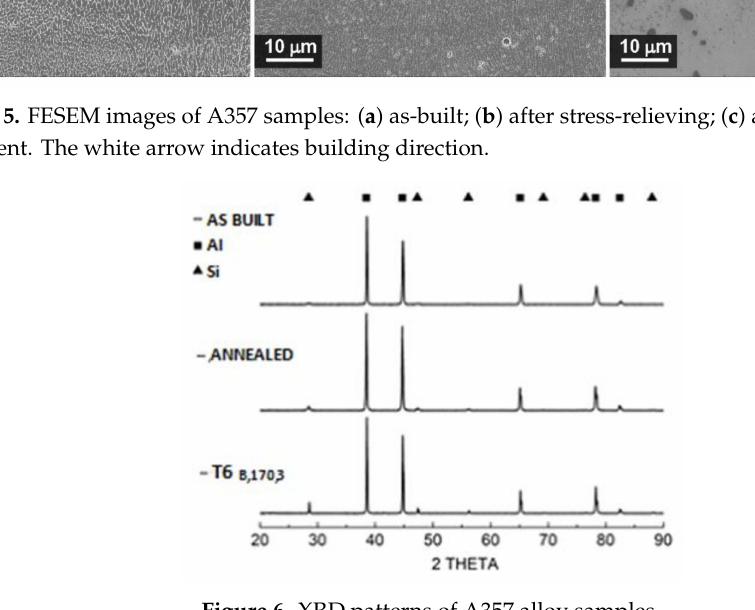
Figure 6. XRD patterns of A357 alloy samples.